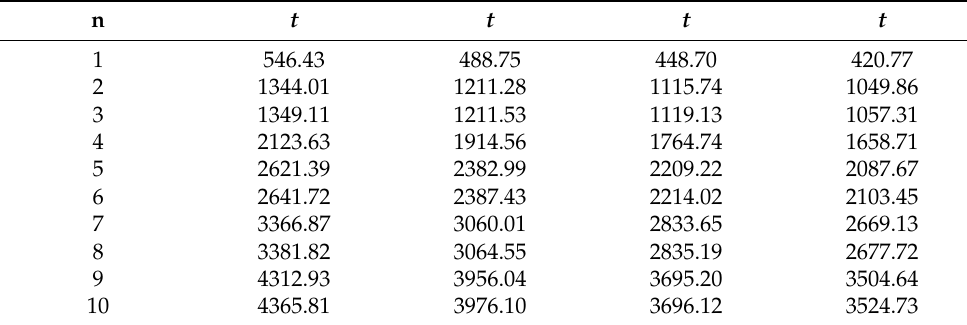
Table 6. Frequencies with thickness of honeycomb wall change.